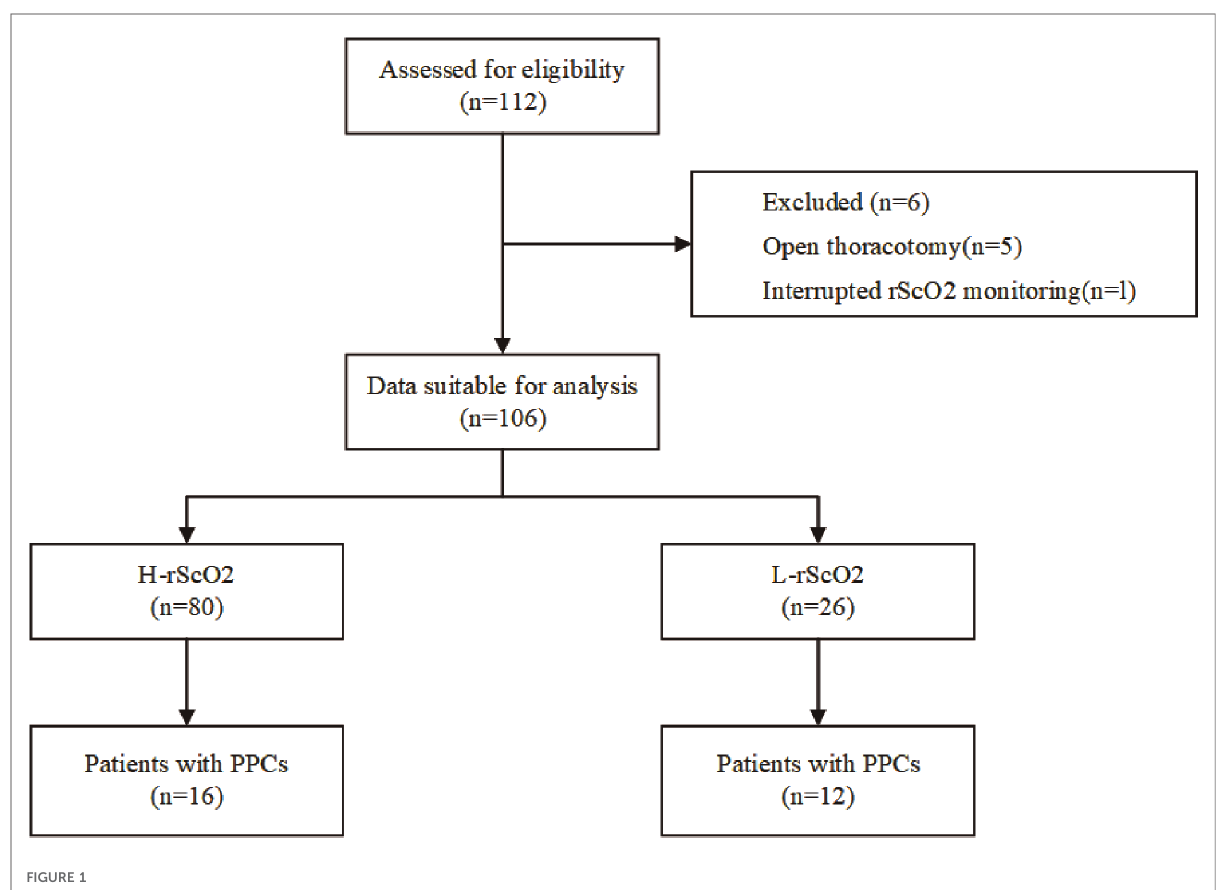
FIGURE 1 Flow diagram of the study participants.